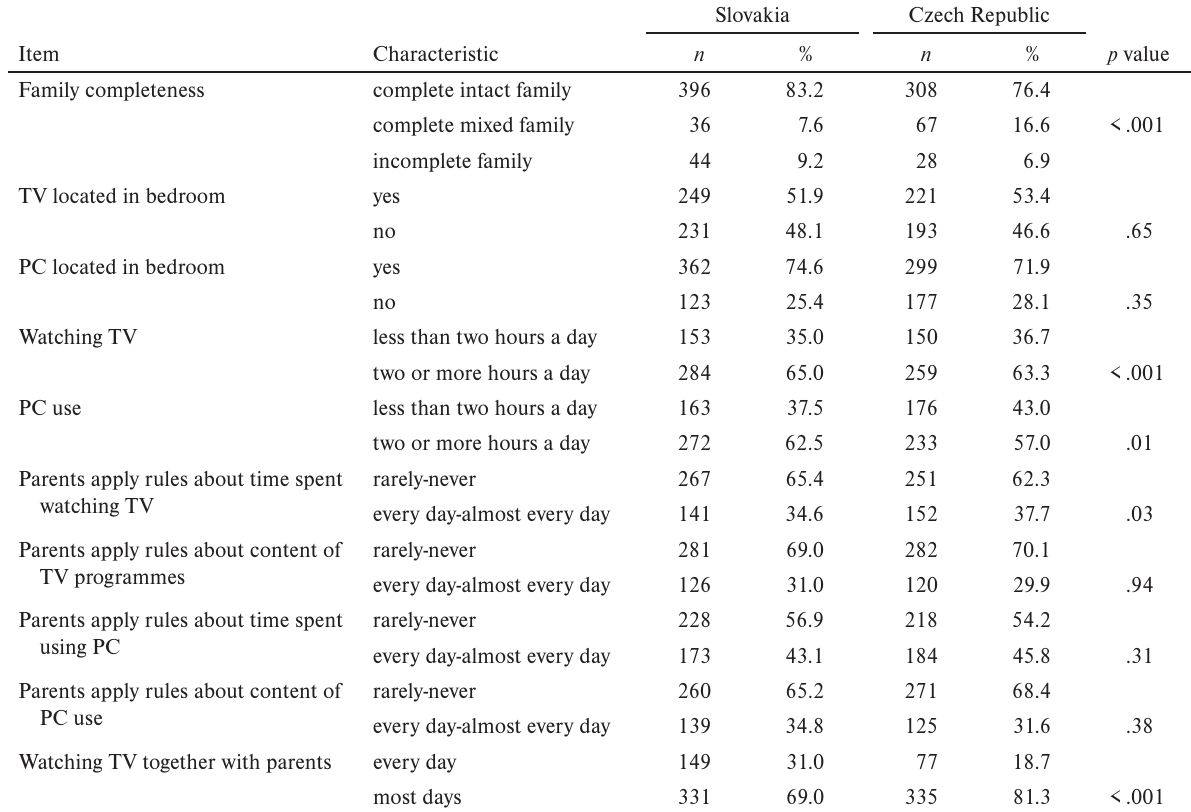
Table 3 Country differences in the prevalence of screen-based behaviour and family-related factors